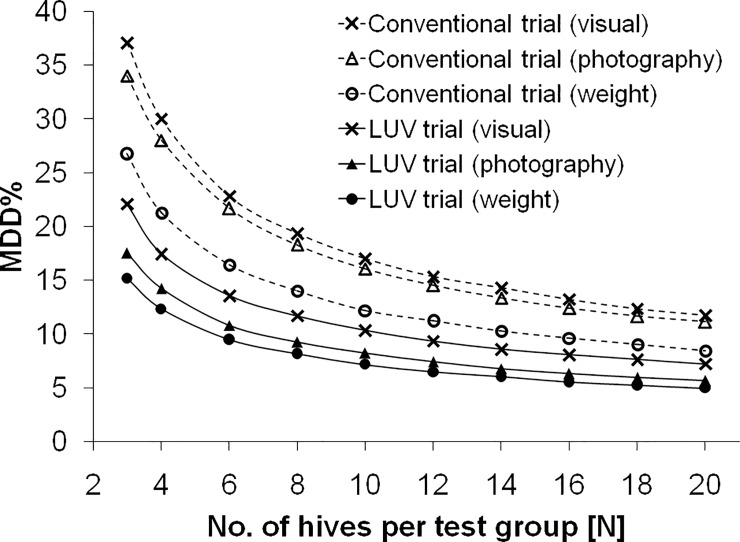
Power curves for the first measurement day in the tunnel (28.4.) showing MDD% values and increasing number of hives per test group assuming either random selection of hives (conventional trial) or the selection of hives as conducted in the present LUV trial (for details see S1 File).